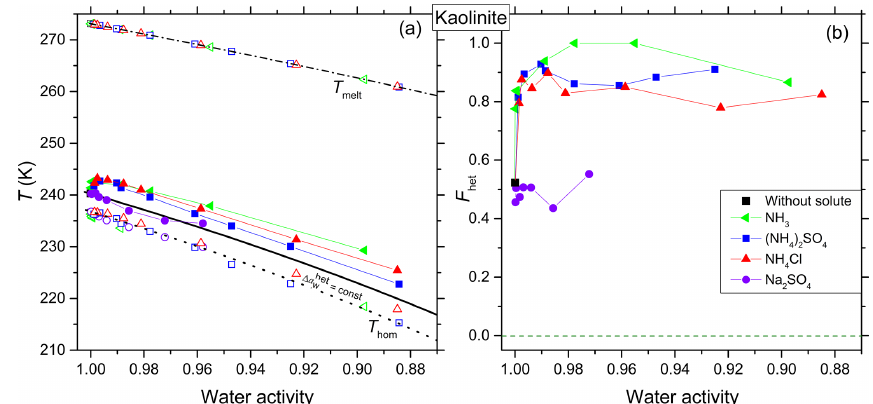
Figure 3. Same as Fig. 2, but for kaolinite (5wt%). (a) Homogeneous ice freezing curve (dotted black line) characterized by a constant offset (cid:49)a hom w (T ) = 0 . 294. Ice melting curve (dash-dotted black line) and the heterogeneous freezing curve (solid black line) horizontally shifted from the ice melting curve by (cid:49)a het w (T ) = 0 . 272 derived from the heterogeneous freezing temperature of the suspension of the mineral in pure water (filled black square at a w = 1). Measured differences and instrumental uncertainties in T het and a w are smaller than the symbol size (see Sect. 2.2). (b) F het (heterogeneously frozen fraction) as a function of water activity of the solutions. Measurement difference and uncertainty in F het do not exceed ±